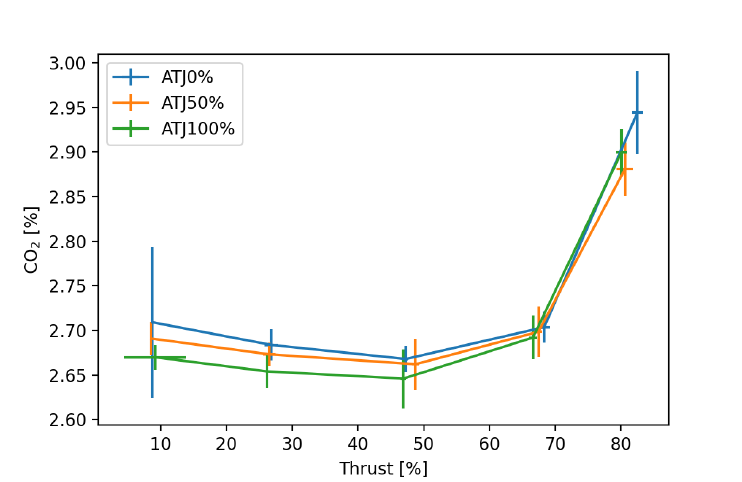
Figure 14. GTM-140/ATJ: CO 2 emission.